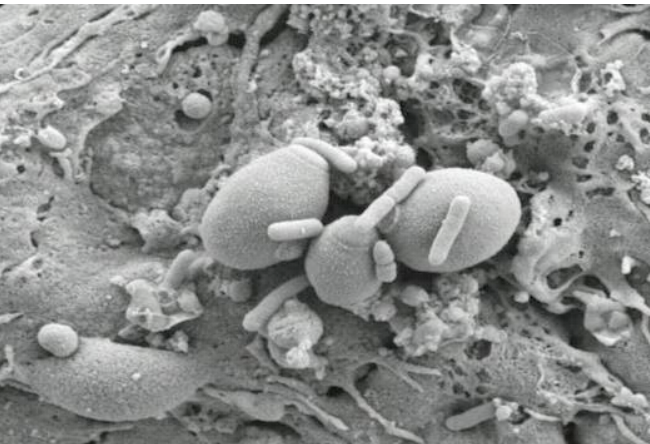
Figure 1 Illustration of the size difference between a yeast probiotic ( Saccharomyces boulardii )